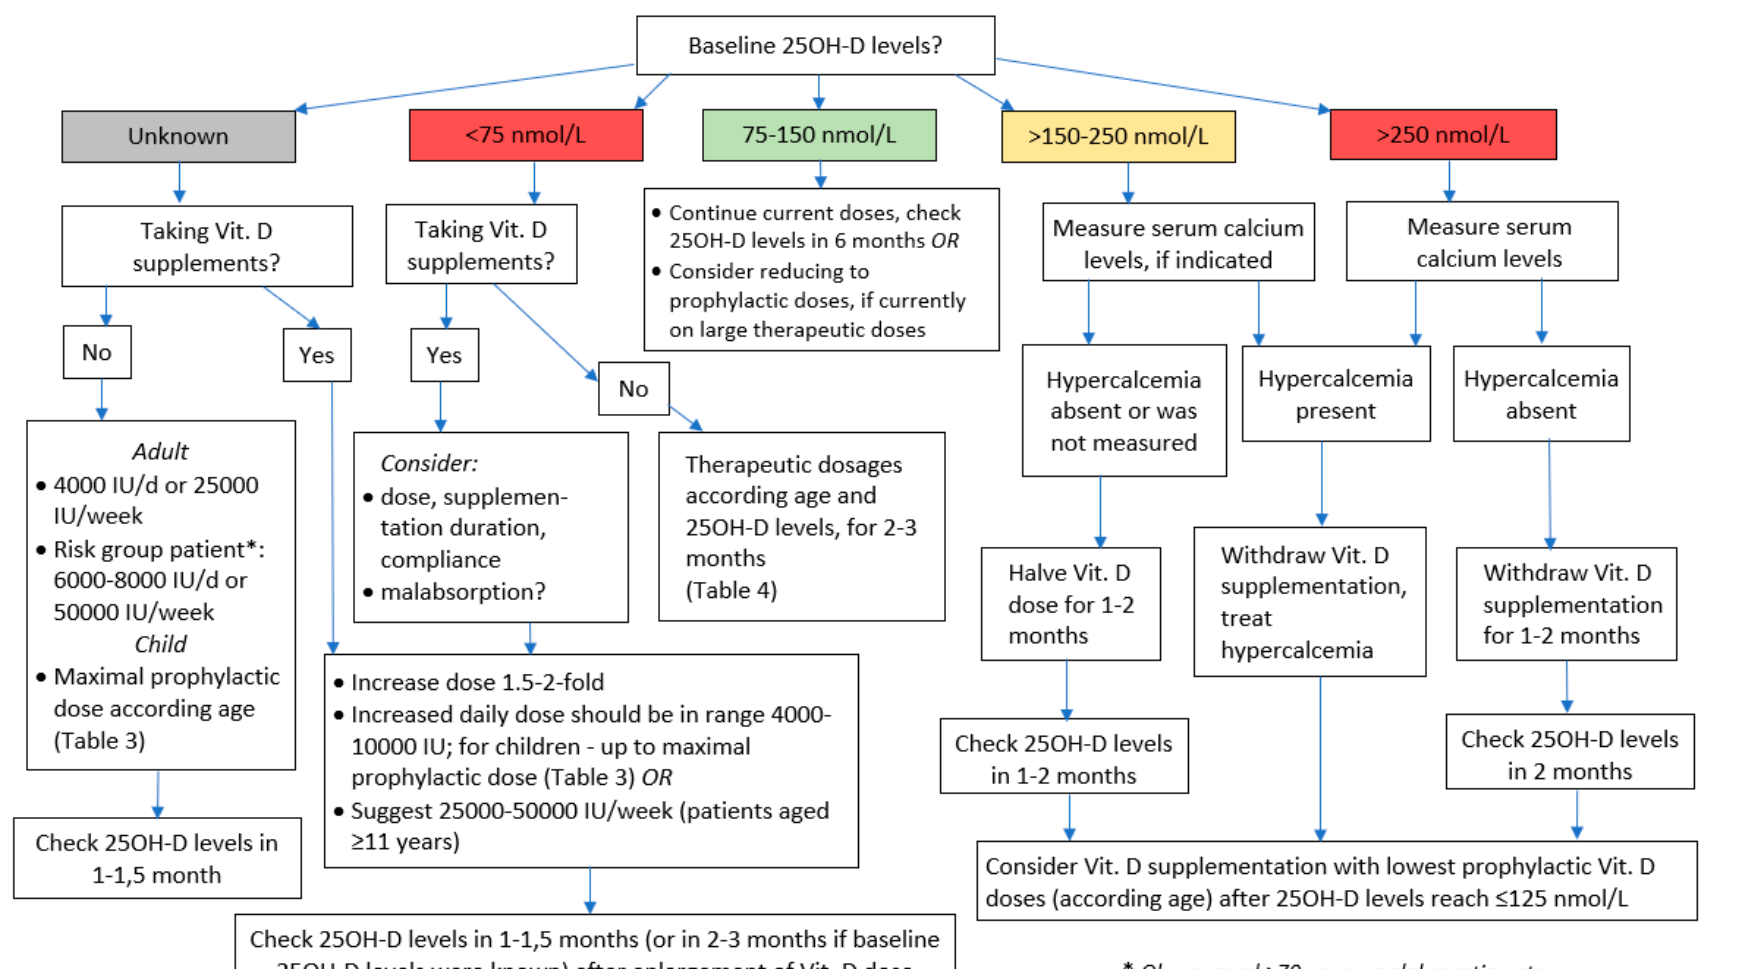
Figure 1. Brief algorithm for vitamin D dosing.